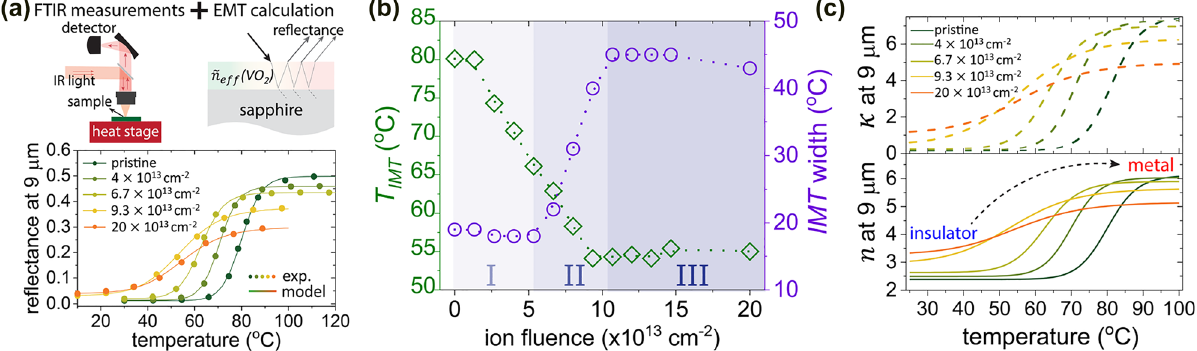
. Figure 4: FIB-induced changes in phase-transition temperature and width of VO 2 (a) Temperature-dependent optical characterization of the FIB-irradiated VO . First, we measured temperature-dependent reflectance across 2 the IMT for each irradiated region. Then, we applied effective-medium theory to approximate the refractive indices at intermediate and E —which determine the IMT temperatures and calculate the temperature-dependent reflectance. By sweeping the parameters of T IMT width and temperature, respectively—in Eq. (4), we found the best fit between the FTIR measurements and calculation, enabling us to extract the IMT temperature and width for each irradiation ion fluence, as plotted in (b). (c) Extracted temperature-dependent refractive indices of irradiated by different ion fluences. Here we plot the results for a single wavelength of 9 μ m to clearly show the the defect-engineered VO 2 evolution of refractive-index values versus temperature and ion